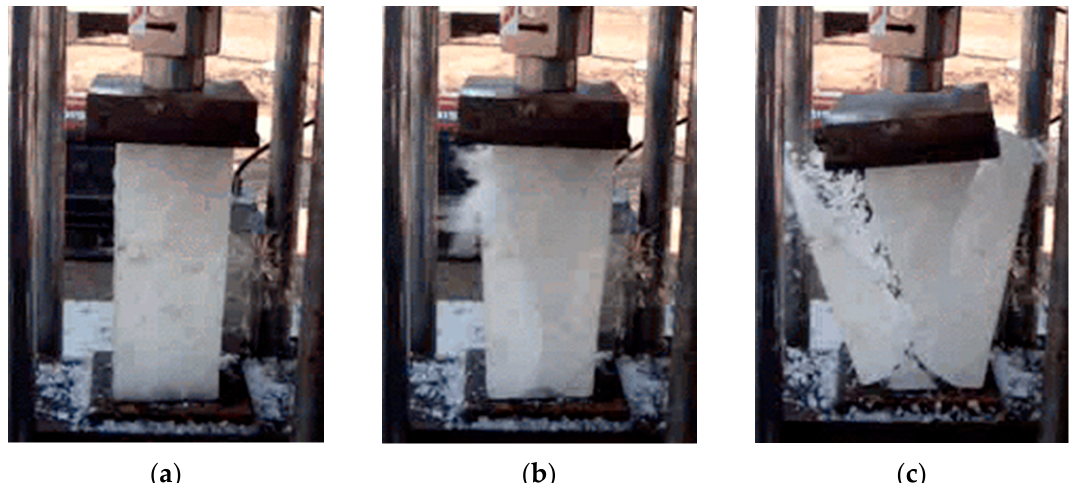
Figure 3. Snapshots of the failure process of sea ice in a uniaxial compression test: ( a ) t = 0.0 s; ( b ) t = 0.05 s; ( c ) t = 0.1 s.